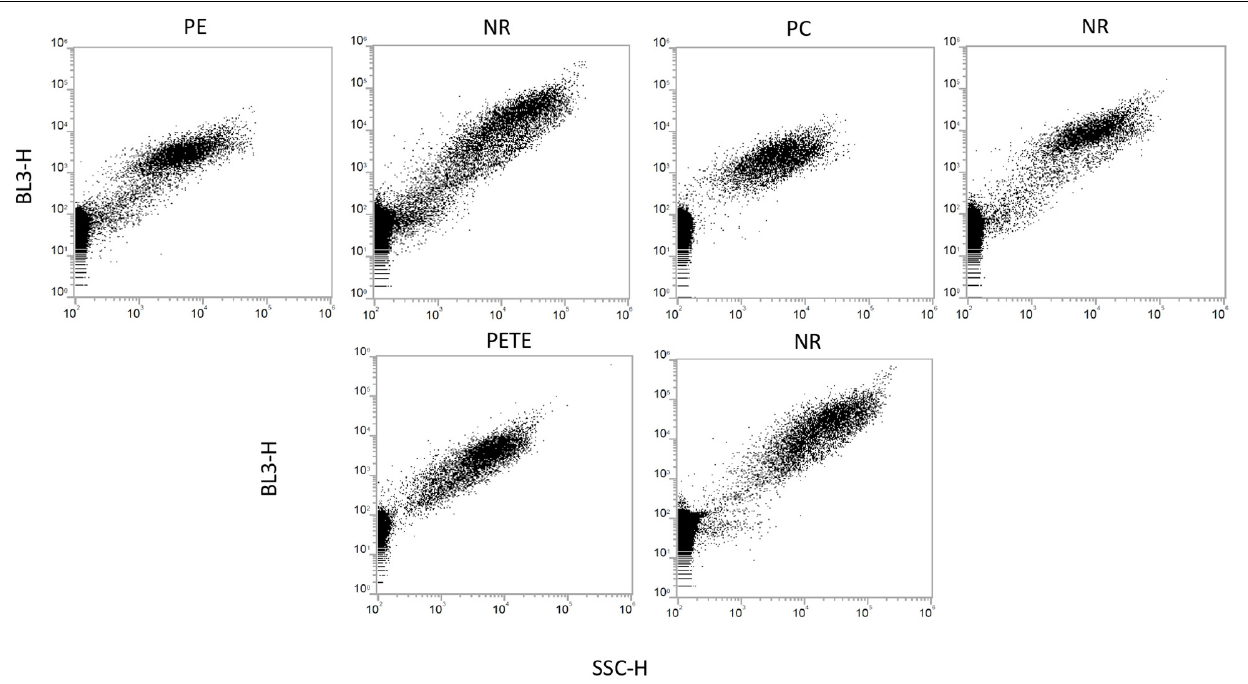
FIGURE 7 | Dot plots for three selected plastic types, polyethylene (PE), polycarbonate (PC), and polyethylene terephthalate (PETE), along with dot plots for NR (without microplastics). All three stained microplastic types are clearly separated from the background noise. NR precipitation is subtracted from the microplastic population to estimate the concentration of microplastics in Table 1 . TABLE 1 | Overview of the concentrations of PE, PC, and PETE measured with microscopy counts and with FCM. Plastic